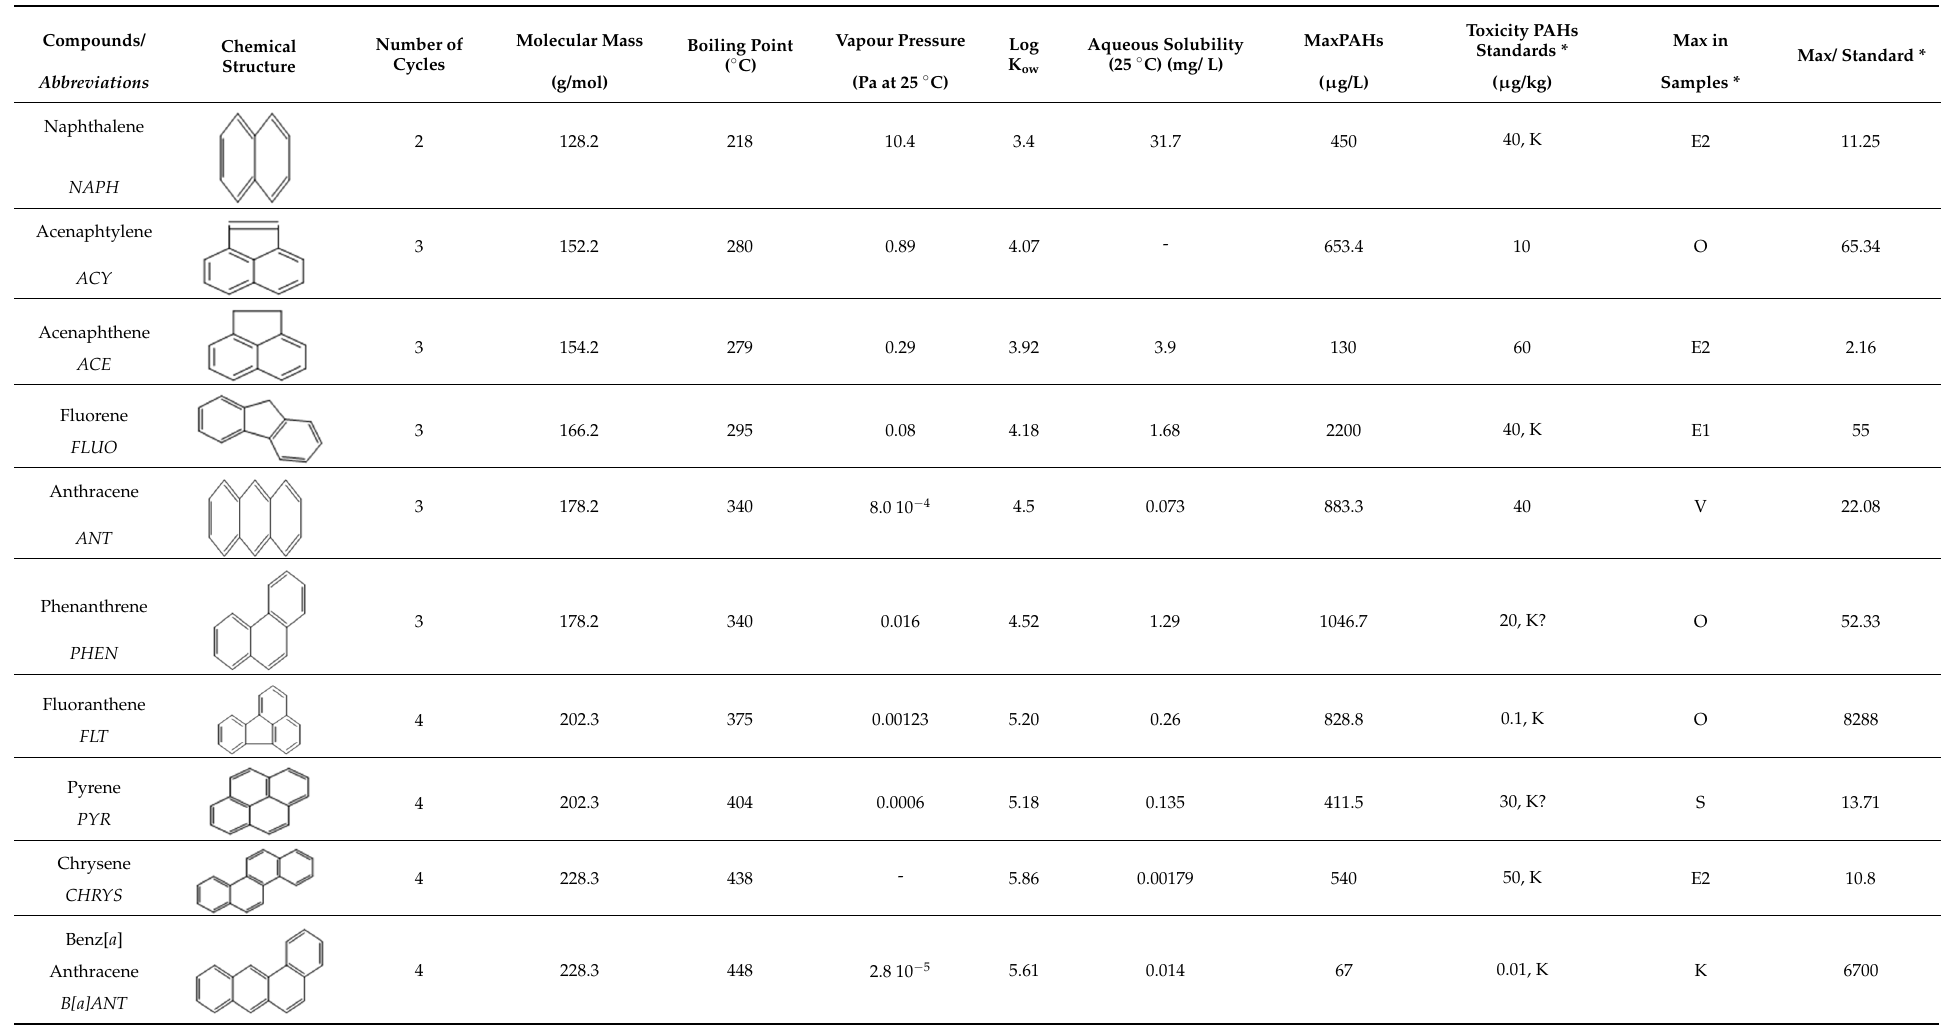
Table 3. Physico-chemical properties of PAHs, toxicity standards and ratios of the maximum PAHs found in the bibliography [23,30].